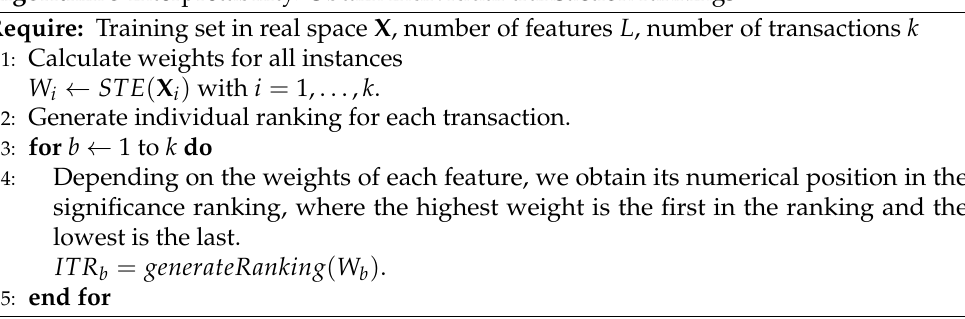
Algorithm 3 Interpretability. Obtain individual transaction